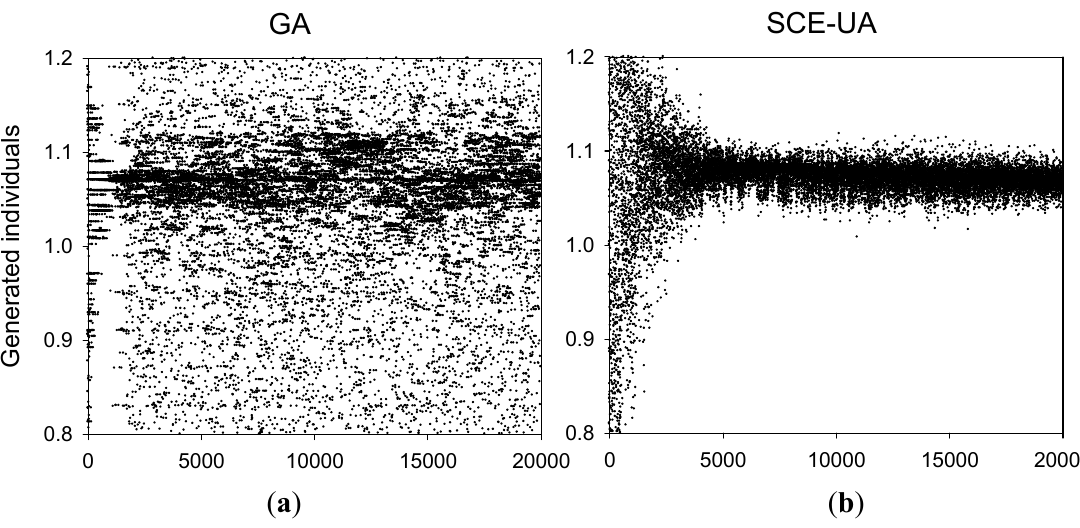
Figure 7. Comparison of generated individuals during evolutionary run between GA and SCE-UA. Number of model runs were 20,000 for SCE-UA and 20,300 (100 individual/generation and 200 generations) for GA. The individual is an optimized parameter of crop land in WD#1 (80% of total area). ( a ) GA generated individuals; ( b ) SCE-UA generated